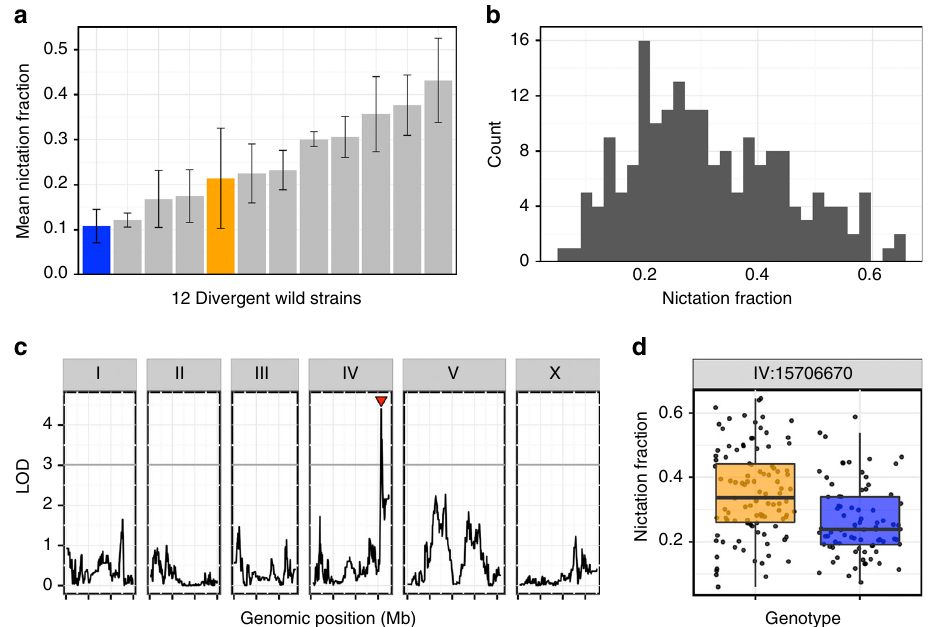
Fig. 1 C. elegans differences in a phoretic behavior map to chromosome IV. a The mean nictation fractions of 12 divergent wild isolates are shown (from left , CB4856 ( blue ), EG4725, ED3017, JT11398, N2 ( orange ), JU258, JU775, DL238, LKC34, CX11314, MY16, and MY23). Twenty-four replicates of CB4856 and three replicates of all other strains were measured to calculate the means. Error bars are standard deviations. b A histogram of the normalized nictation fractions of 186 N2xCB4856 recombinant inbred advanced intercross lines (RIAILs) is shown. c Linkage-mapping results of normalized nictation fraction are shown with genomic position (Mb) on the x -axis and logarithm of odds (LOD) score on the y -axis. The tick marks on the x -axis denote every 5 Mb. Each chromosome is in its own box labeled on top . The gray line is the LOD threshold for 5% genome-wide error rate obtained by permuting the phenotype data and mapping 1000 times. The red triangle denotes the peak QTL marker. d Tukey box plots of N2 ( orange ) and CB4856 ( blue ) are shown with data points plotted behind. The horizontal line in the middle of the box is the median, and the box denotes the 25th to 75th quantiles of the data. The vertical line represents the 1.5 interquartile